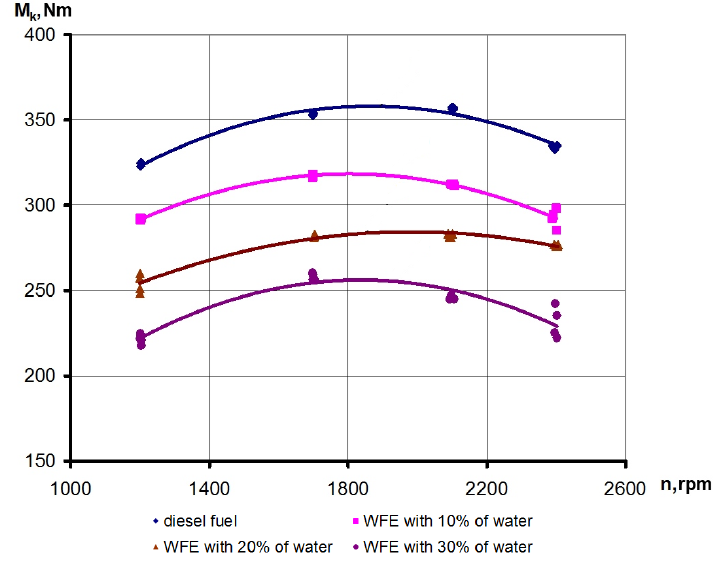
Figure 4. Engine torque depending on the engine speed when working on diesel fuel and water–fuel